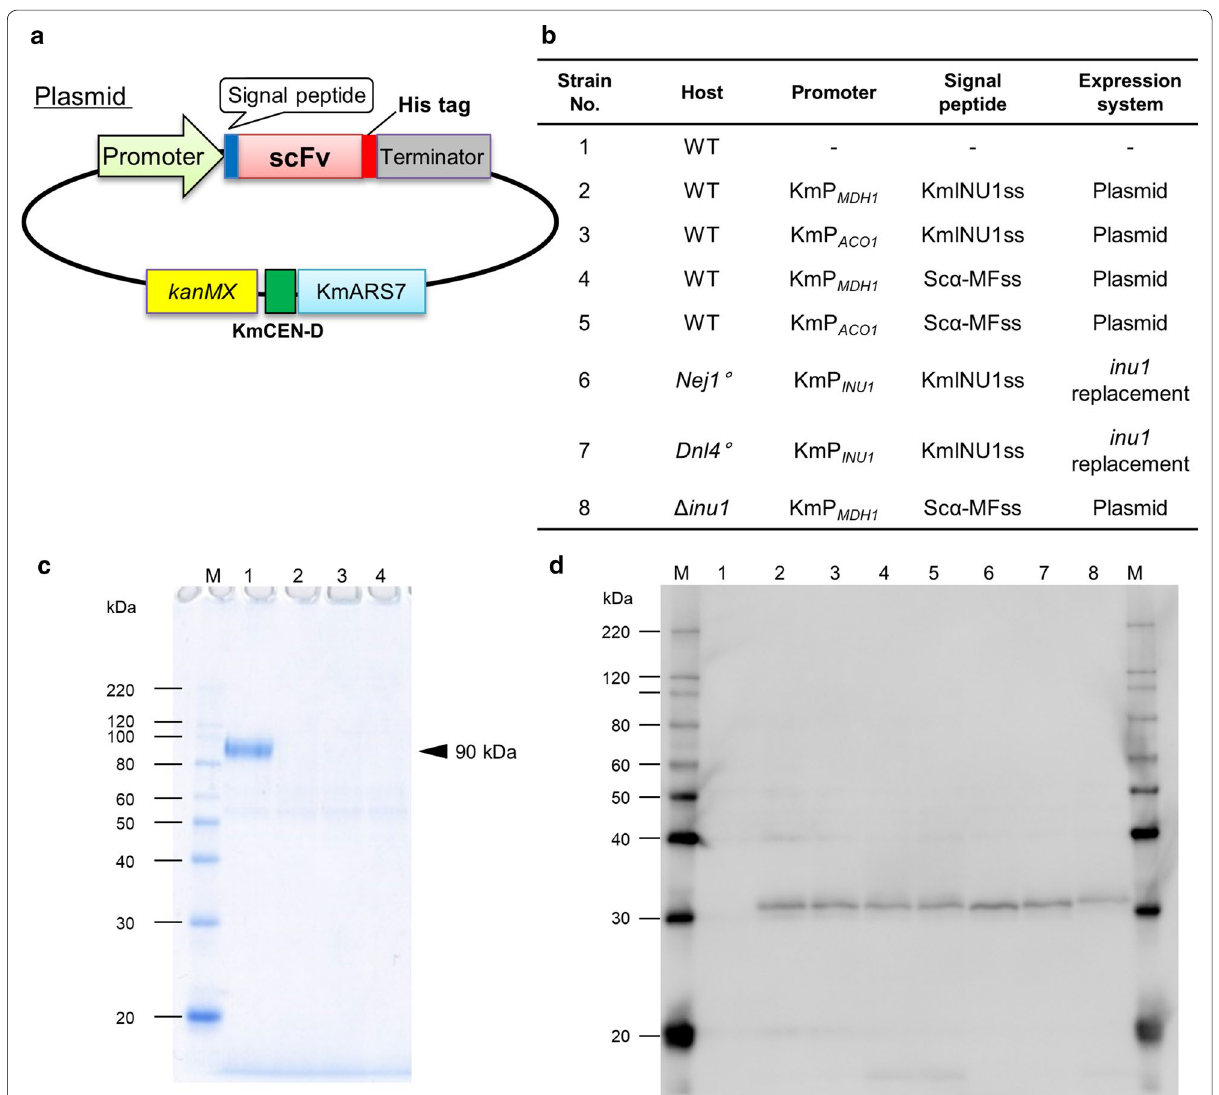
Fig. 3 INU1 deletion analyzed by SDS‑PAGE and secretion of scFv analyzed by immunoblotting. a Schematic of the general construction of scFv‑ expression plasmid. kanMX : G418 resistance gene, KmCEN‑D: centromere sequence of K. marxianus , KmARS7: autonomous replication sequence of K. marxianus . b Combinations of promoters and signal peptides tested. c Stains were cultivated for 48 h in YPD with or without G418, and SDS‑PAGE was used to analyze the spent culture medium from strains No. 1 (wild‑type) (lane 1), No. 6 (Km02‑064) (lane 2), No. 7 (Km02‑065) (lane 3), and No. 8 (Km02‑066) (lane 4). Sizes of the molecular weight marker (lane M) are indicated on the left. d Immunoblot of spent culture medium from strains cultivated for 72 h in YPD with or without G418. Lane numbers correspond to those in panel